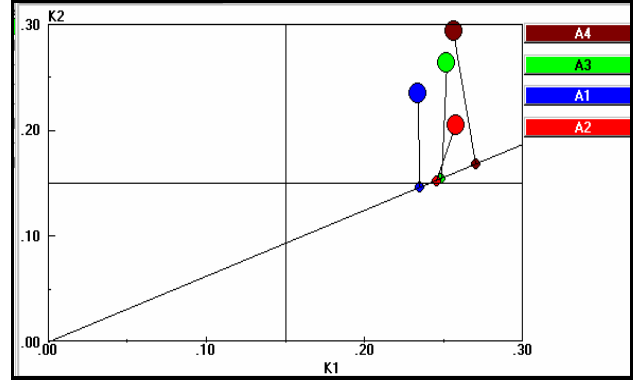
Figure 7 – Two-dimensional sensitivity analysis at the problem